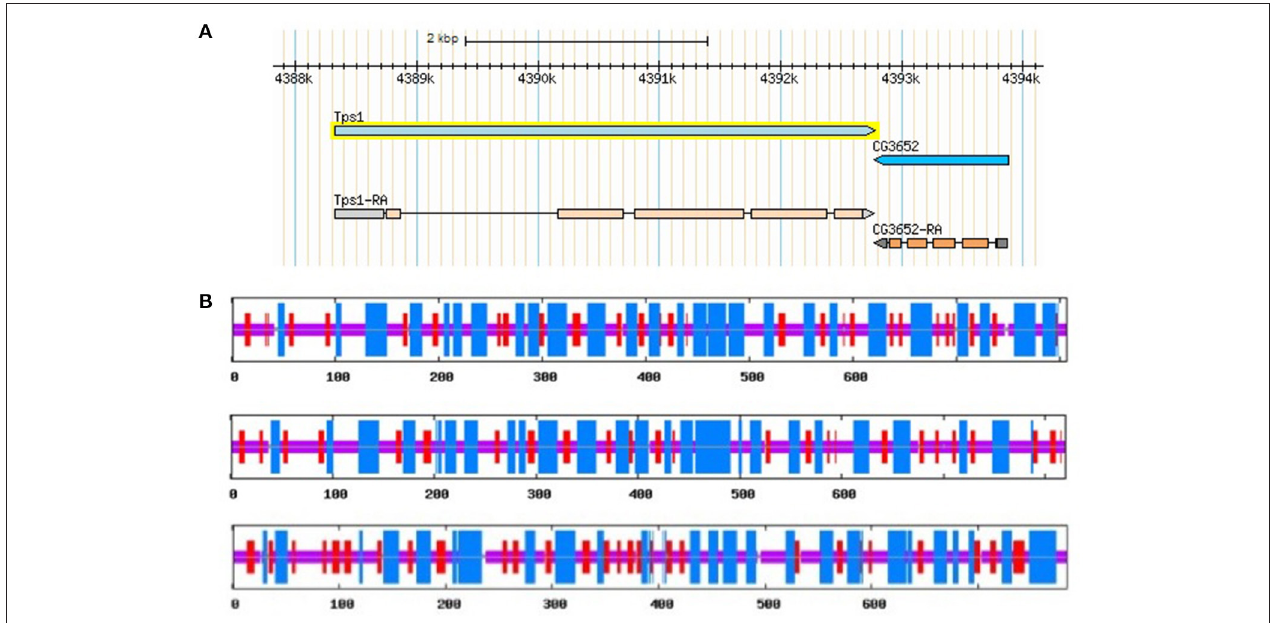
FIGURE 3 | D. melanogaster TPS genomic structure (A) from FlyBase and predicted secondary structures of three TPS proteins of the brown planthopper, including TPS1, TPS2, and TPS3 (B). Blue and red regions represent α -helixes and β -sheets in Figure 3B ,